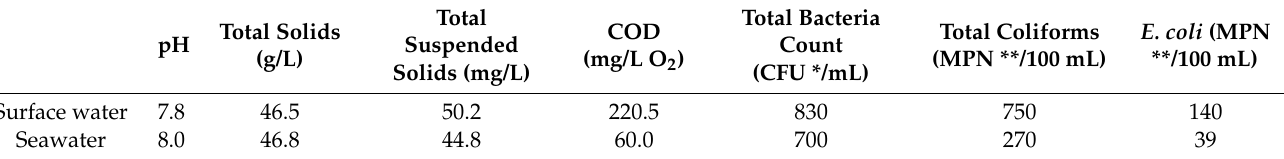
Table 1. Characterization of the surface and sea water used in the static (bio)fouling experiments.